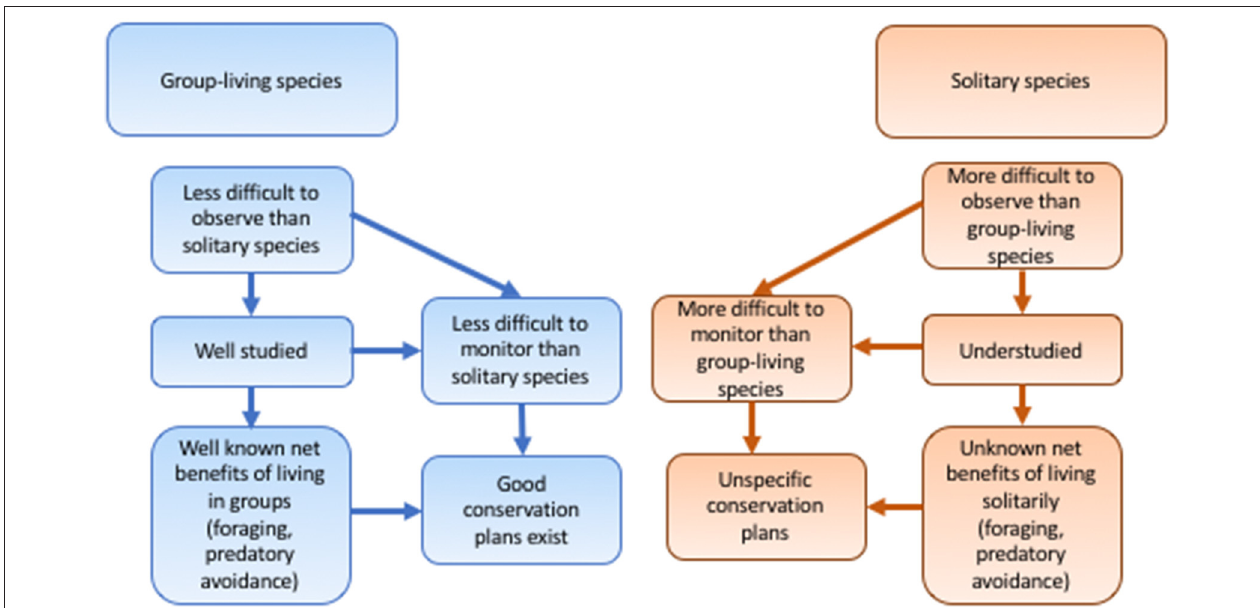
FIGURE 1 | While social species (left) are well-studied and understood with regards to their social biology, solitary species (right) are understudied. This is likely to affect the quality of species specific conservation plans (middle)